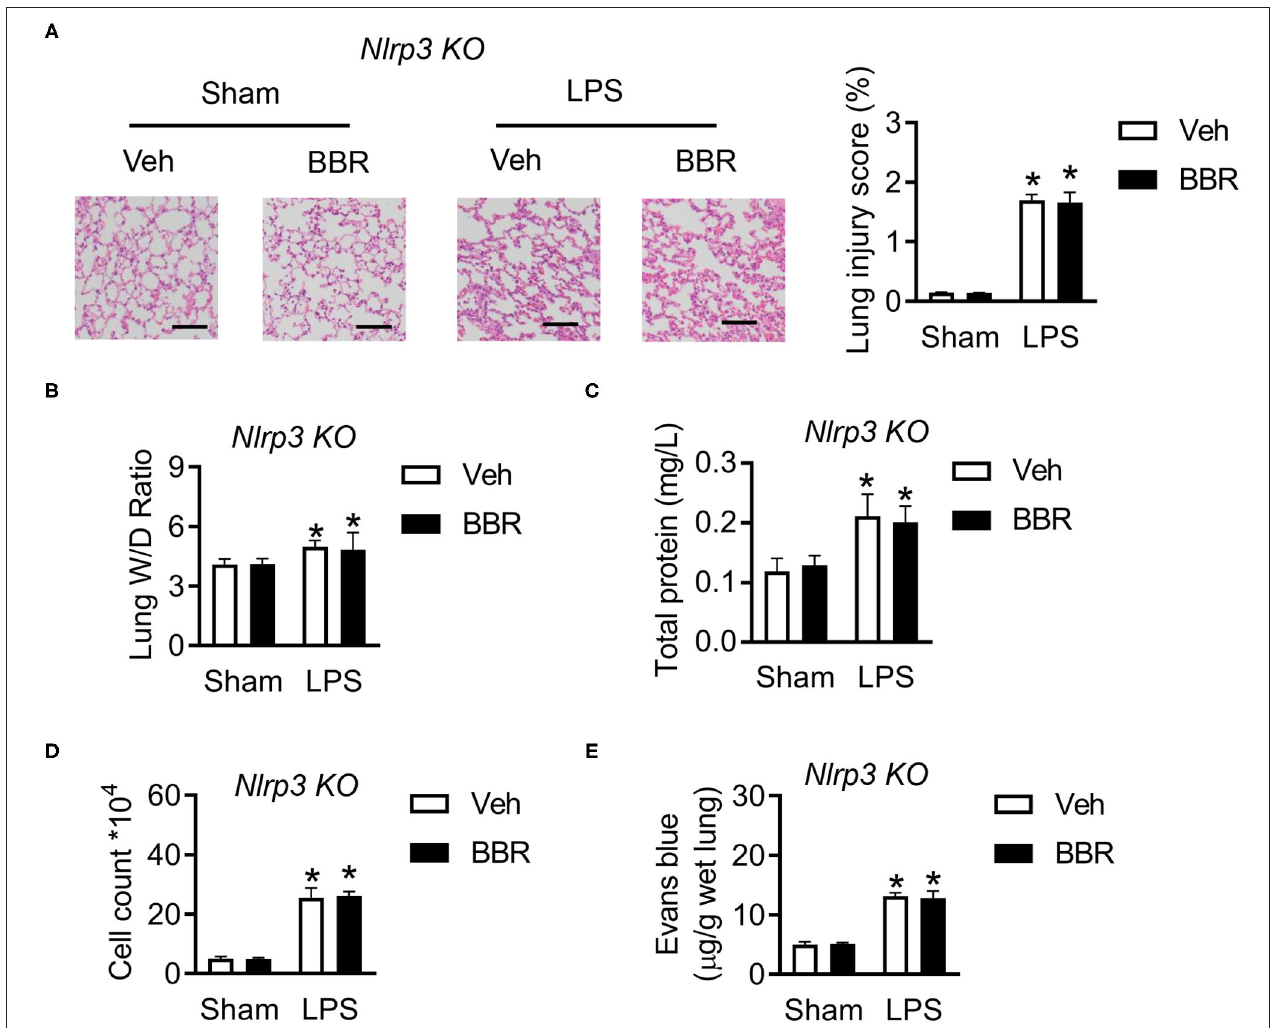
FIGURE 7 | Deletion of Nlrp3 in mice abolished the protective role of BBR in ALI. (A) The H&E staining and lung injury score in pulmonary section, n = 3, scale bar = 100 µ m. (B) The ratio of wet lung to dry lung, n = 8. (C,D) The detection of total protein and cell counts in BALF, n = 8. (E) The concentration of Evans blue in lung tissue, n = 8. Data were expressed as mean ± SD. Statistical significance is indicated as * P < 0.05 vs. the sham + vehicle groups. ALI, acute injury lung; BALF, bronchoalveolar lavage